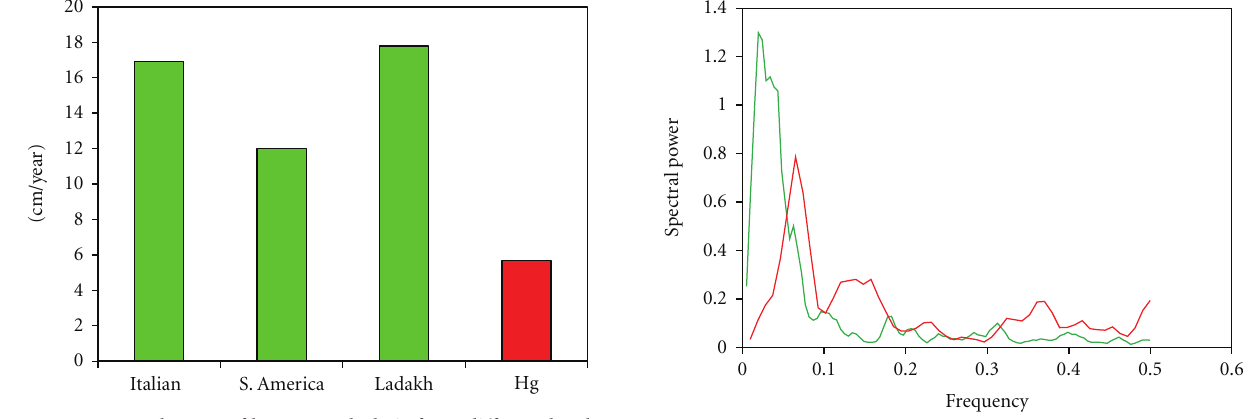
Figure 2: Growth rates of human scalp hair from di ff erent locales and from Huancavelica (Hg). Significantly slower yearly growth ( ∼ 6cm/year) is evident in modern residents of Huancavelica.